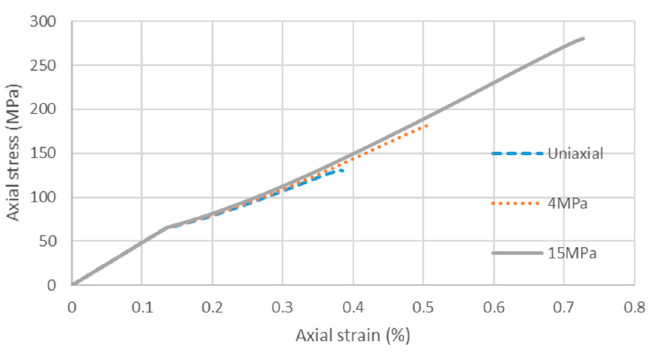
Figure 8. Effects of confining pressure on stress-strain response in compression tests.